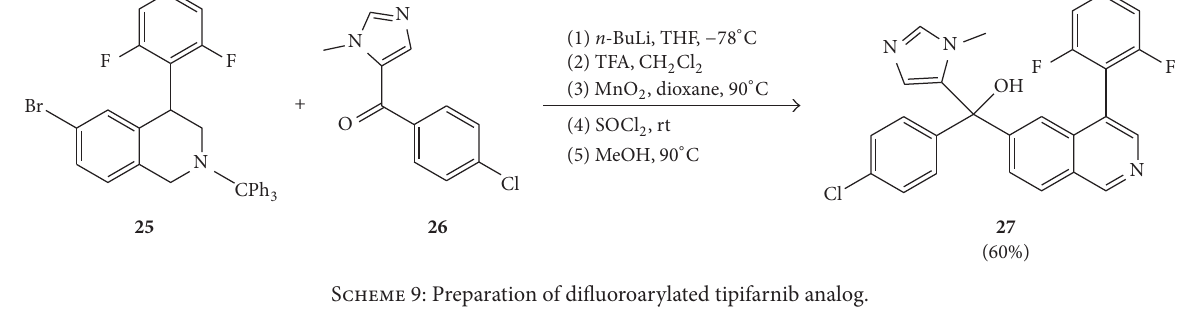
Scheme 9: Preparation of difluoroarylated tipifarnib analog.